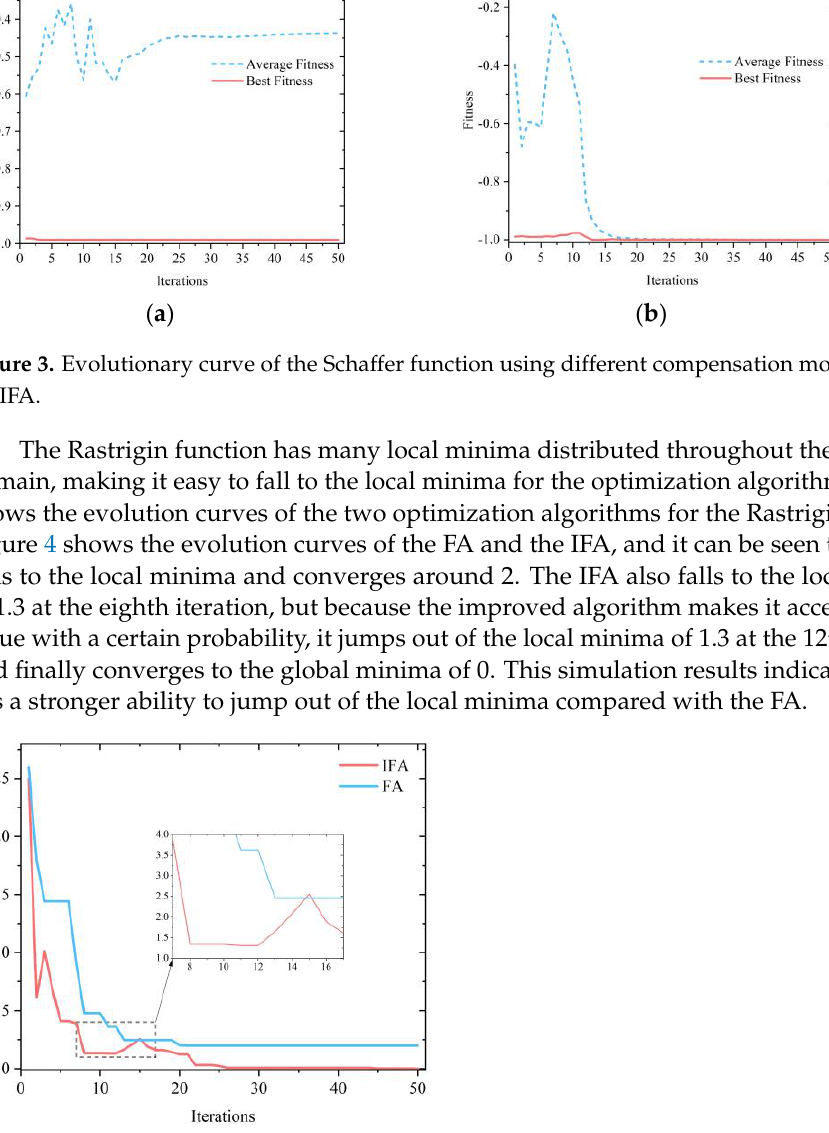
Figure 2. Images of the two test functions: ( a ) Schaffer function; ( b ) Rastrigin function.